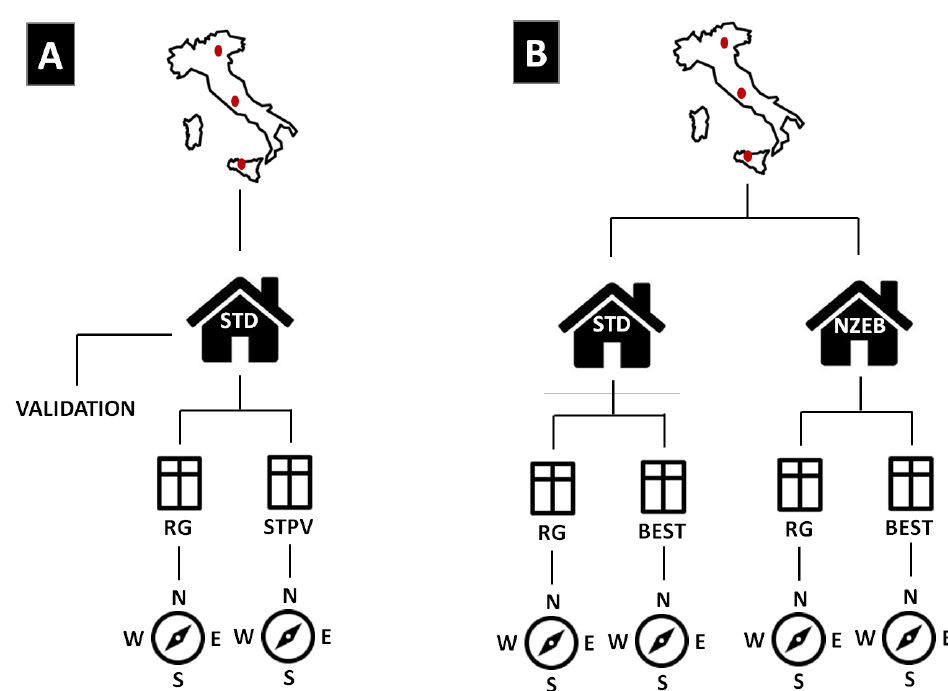
Figure 1. Schematic of the method of investigation used in Phase ( A ) and Phase ( B ) of the study.